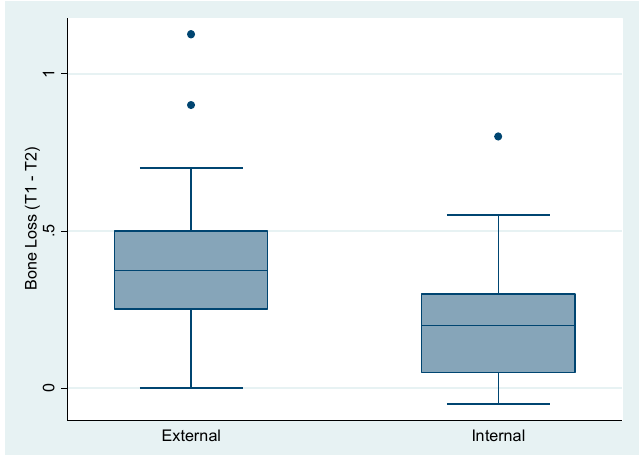
Figure 4. Bone loss (mm) in internal vs. external connection implants between the first and second measurements ( T 0– T 1).